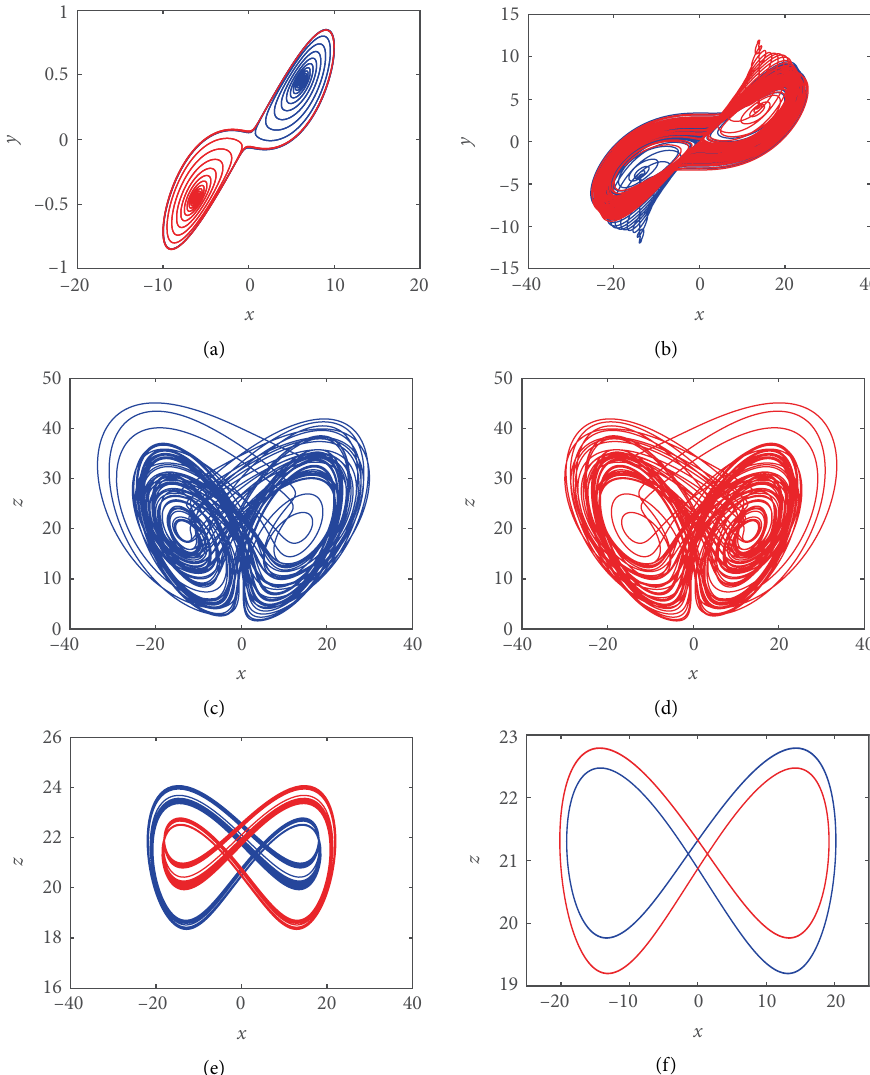
Figure 11: Symmetrical coexistent attractors of the system on the 𝑥 - 𝑦 , 𝑥 - 𝑧 plane.